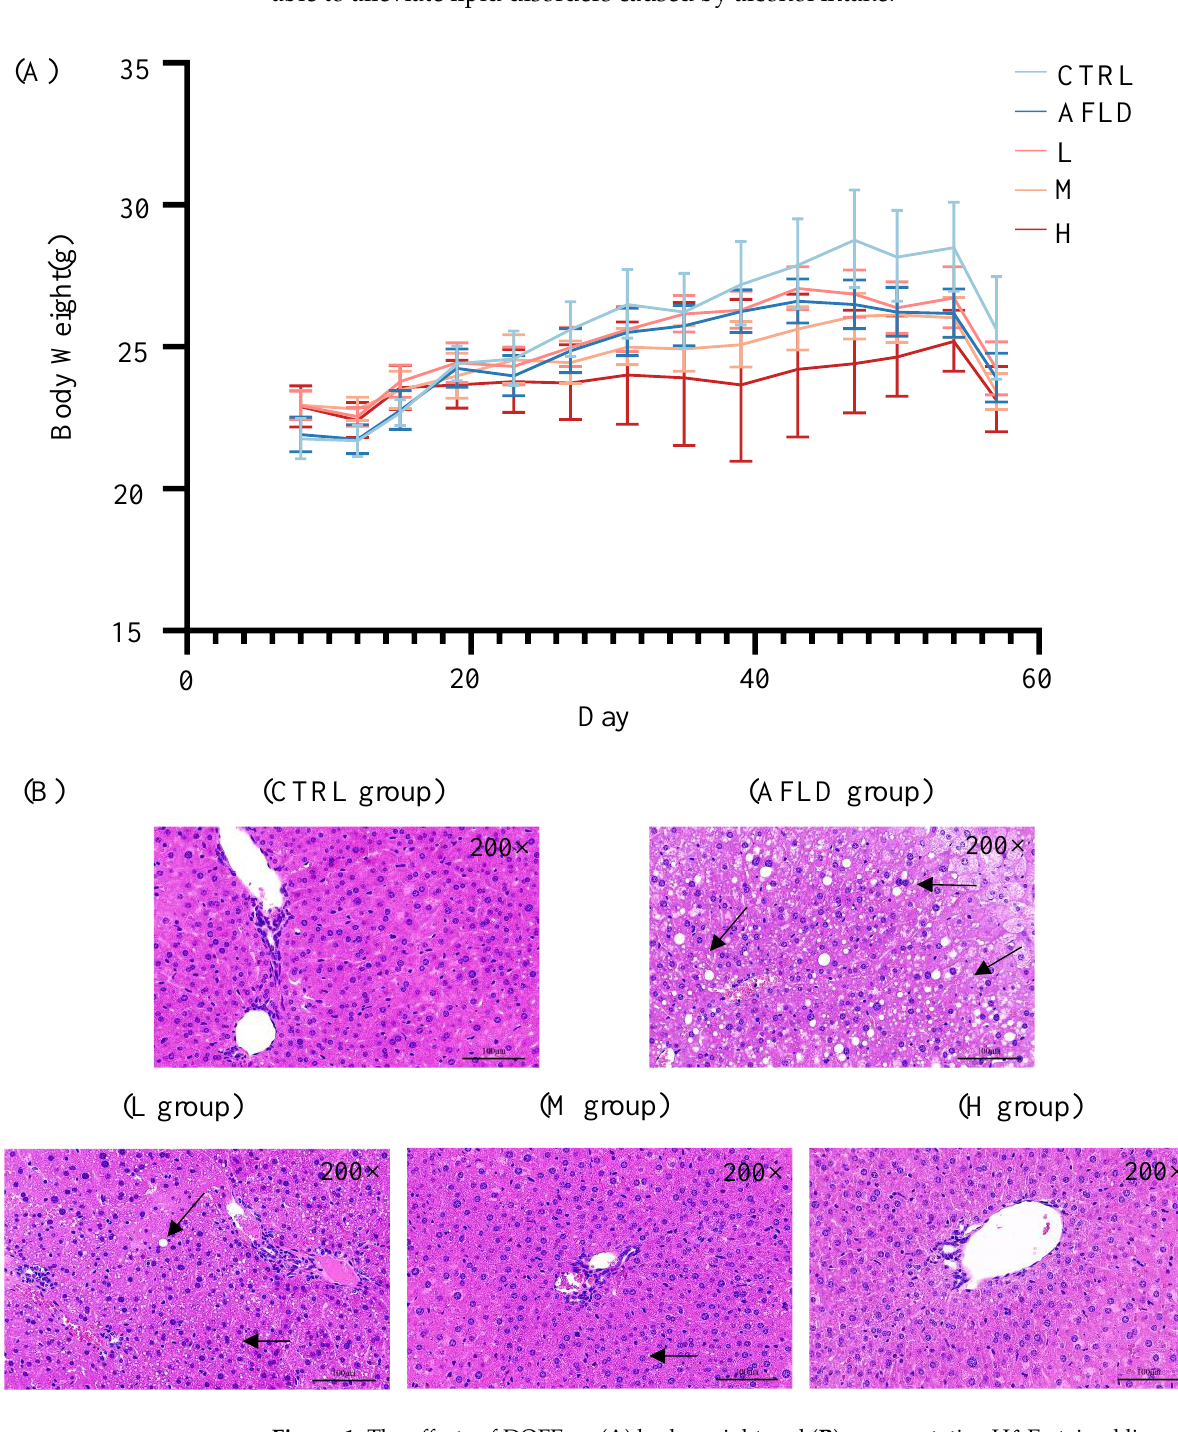
Figure 1. The effects of DOFE on ( A ) body weight and ( B ) representative H&E-stained liver sections from mice exposed to chronic alcohol consumption (magnification: 200, scale bar: 100 μm). CTRL, the control group; AFLD, the model group; DOFE, Dendrobium officinale flower extract; L, the low concentration of DOFE; M, the medium concentration of DOFE; H, the high concentration of DOFE. Black arrows point to inflammatory infiltration.